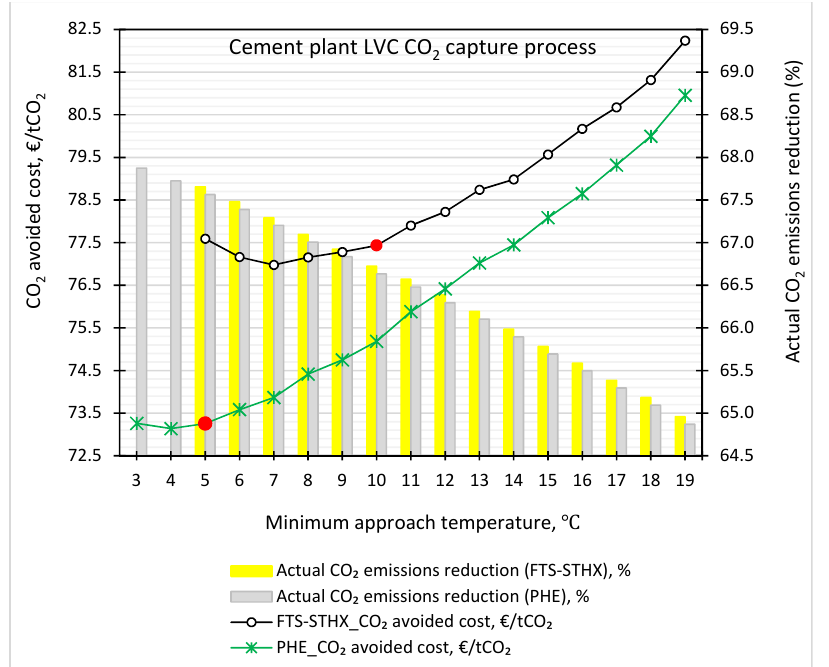
Figure 14. Energy and heat exchanger costs trade-off analysis at different ∆𝑇 (cid:3040)(cid:3036)(cid:3041) for different heat exchanger types in an LVC CO 2 capture process from cement flue gas with consideration of actual CO 2 emissions reduction (red dot is the ∆𝑇 (cid:3040)(cid:3036)(cid:3041) where optimum CO 2 capture cost is achieved, which can be different from the CO 2 avoided cost optimum ∆𝑇 (cid:3040)(cid:3036)(cid:3041) ). The ∆𝑇 (cid:3040)(cid:3036)(cid:3041) in the lean/rich heat exchanger has a significant impact on the steam con-